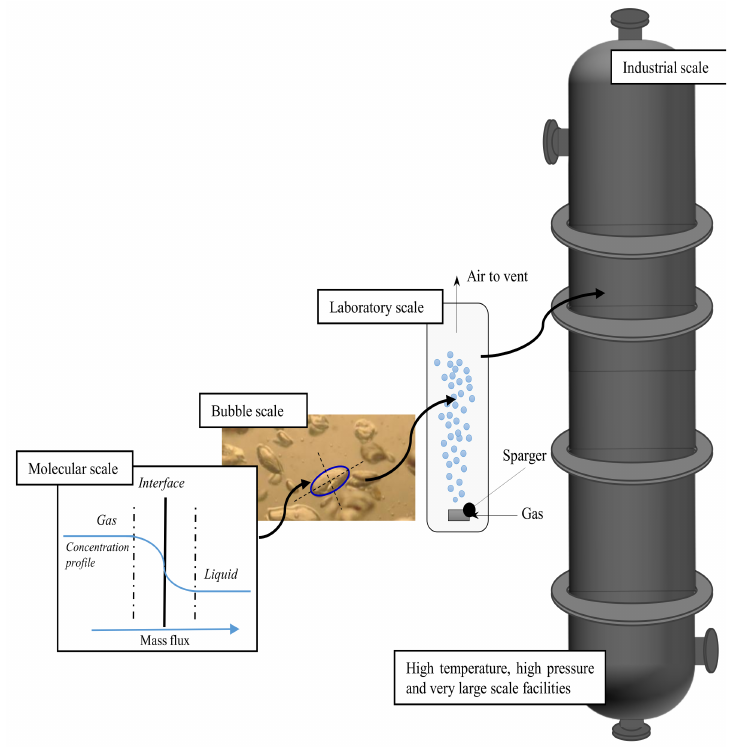
Figure 1. The multi-scale approach to study bubble column fluid